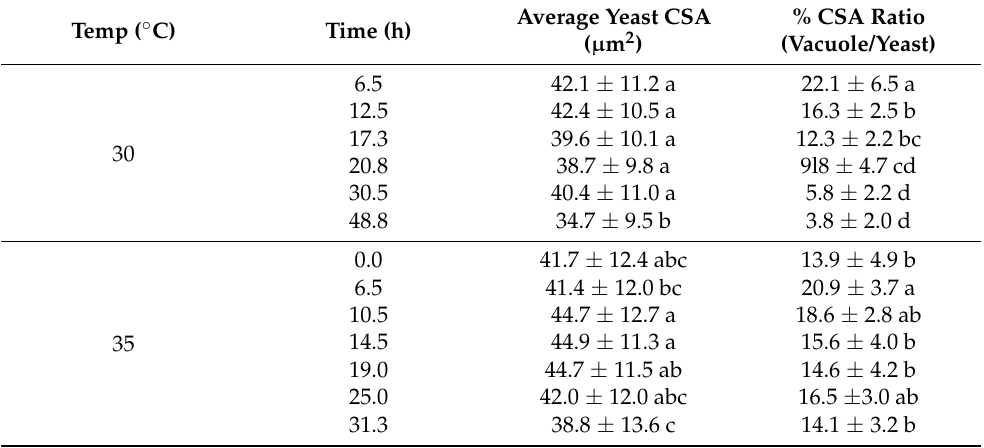
Table 3. Average and standard deviation of yeast CSA and Ratio (vacuole to yeast area) summary *. Temp ( ◦ C)